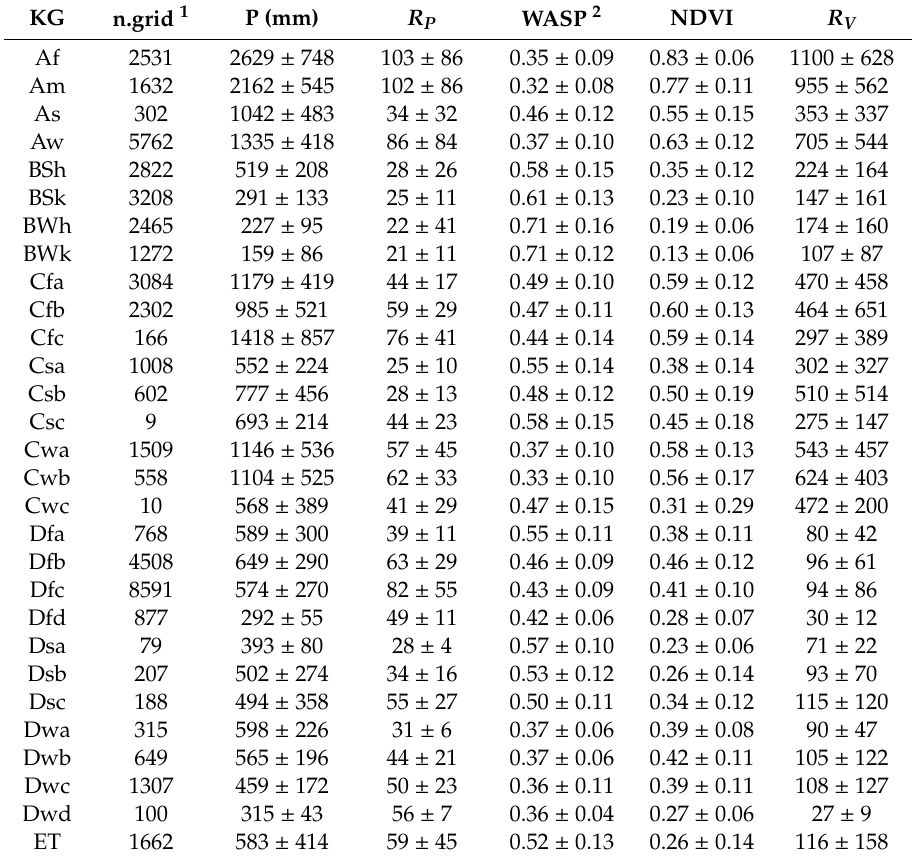
Table 2. Precipitation, drought and NDVI statistics averaged per climate class